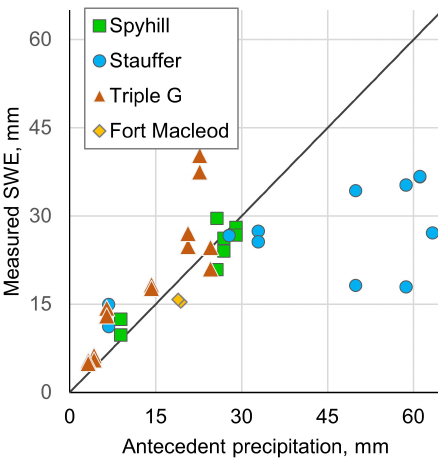
Figure 5. Measured SWE at the study sites versus antecedent pre- cipitation (total precipitation that occurred since the end of the last preceding snow-free